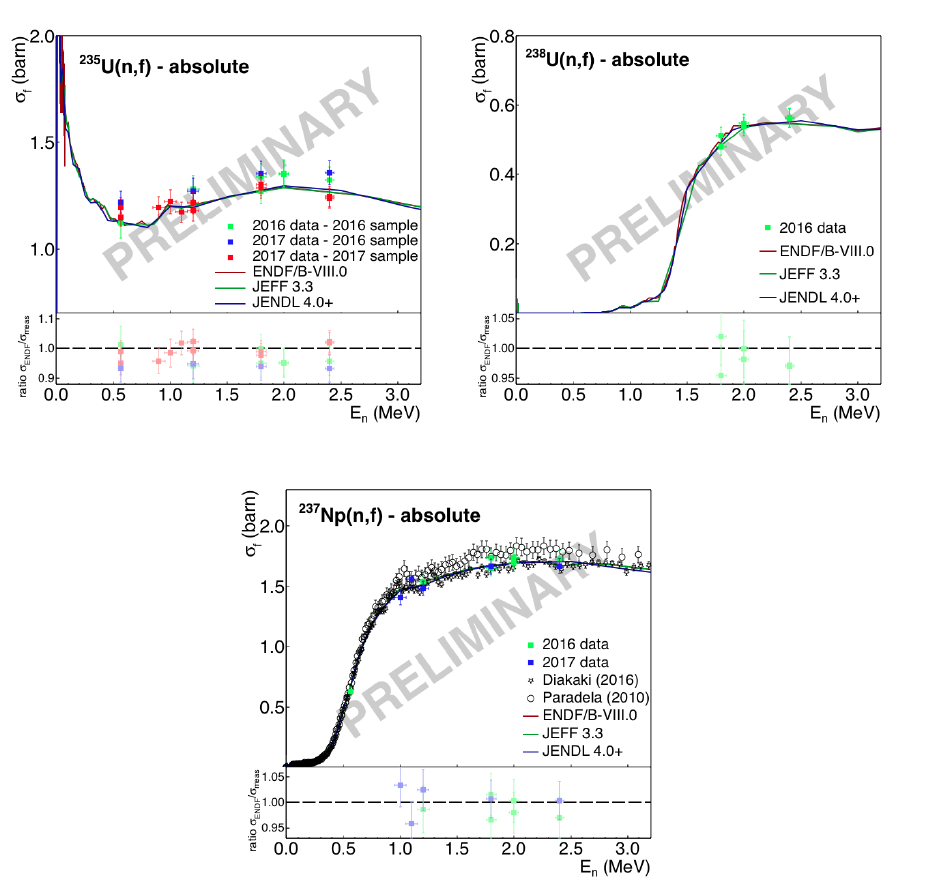
Figure 2. Preliminary results obtained via the absolute measurement for the 235 U, 238 U and 237 Np. The data is compared to the ENDF / B-VIII.0, the JEFF 3.3 and the JENDL 4.0 + evaluation. In addition, the 237 Np is compared to the experimental data from Paradela et al. [1] and Diakaki et al. [5]. For each case, the ratio between the measured data and the ENDF / B-VIII.0 evaluation is also shown. See text for further